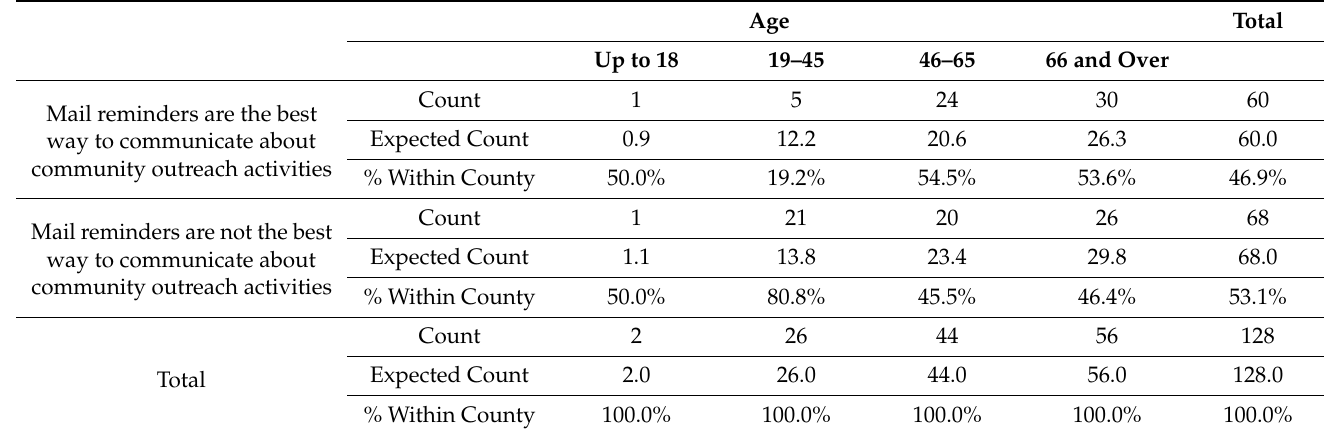
Table 17. Mail Reminders as the Best Way to Communicate to Respondents about Community Outreach Activities by Age.